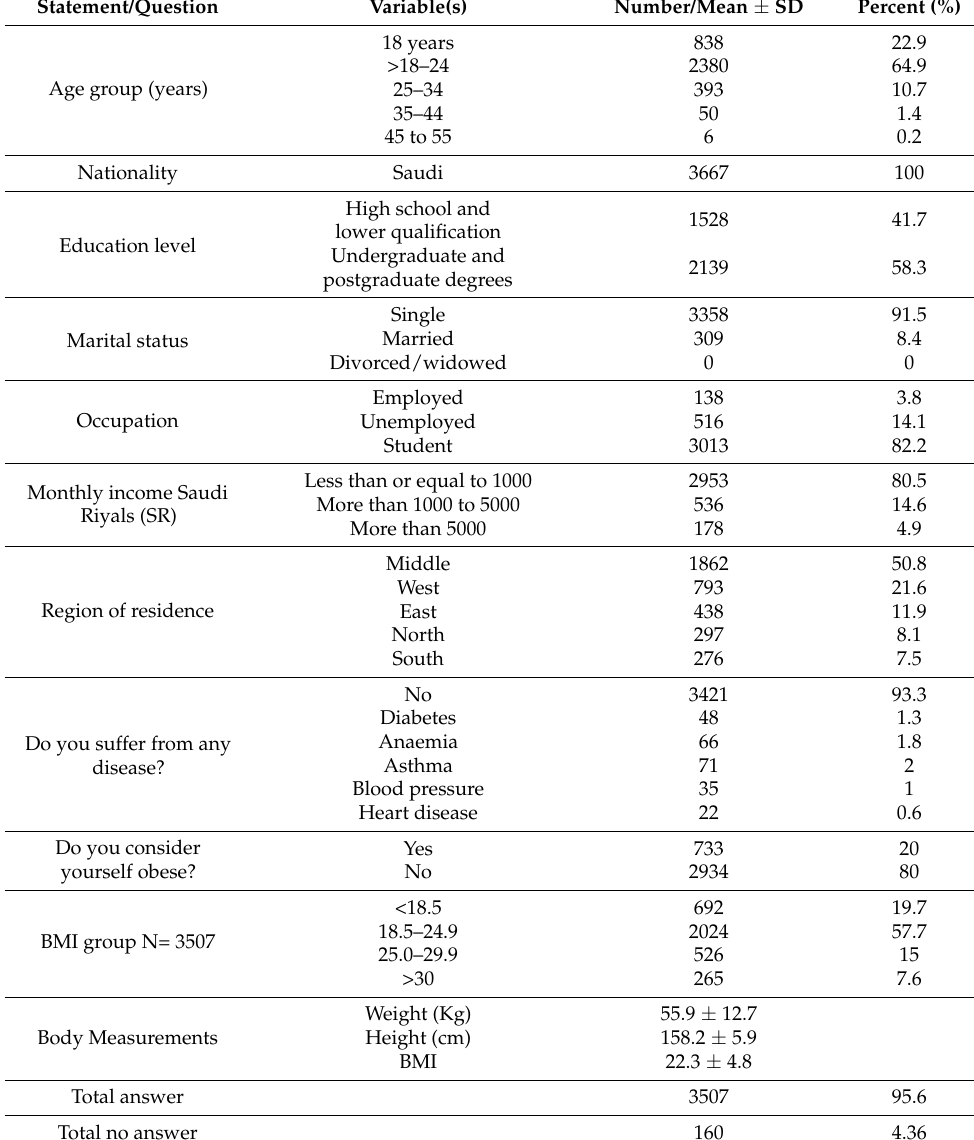
Table 1. Sociodemographic and personal characteristics of the participants (n =